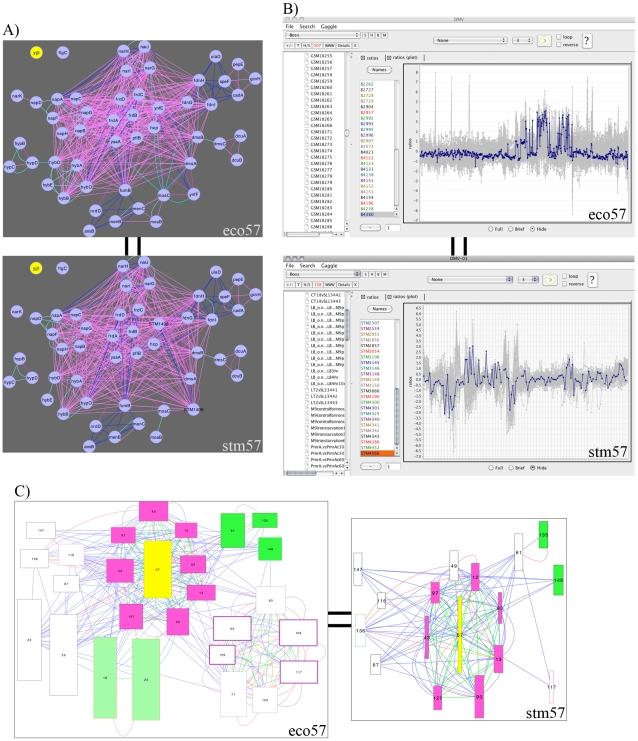
CMMR linked Gaggled tools I: Gene Network, Data Matrix Viewer, Bicluster Network.Expanding the Gaggle tools tab on the BiclusterCard for multi-species bicluster E. coli – S. Typhimurium bicluster 57, reveals a list of links (buttons) to the various Gaggle tools. (A) The Gene Associations button opens a Cytoscape goose that displays the core genes subnetwork for eco57 (top) and stm57 (bottom). The nodes represent genes and edges represent associations based on data from the compendium, indicated in yellow is gene yjjI. Edges are shared annotations: COG code (pink), Prolinks phylogenetic profile (purple), metabolic pathway (blue), operon (light cyan), and Predictome phylogenetic pattern (dark cyan). (B) The expression profiles for the genes and conditions from eco57 (top) and stm57 (bottom) can be explored by opening the Data Matrix Viewer. Using the FireGoose, the bicluster's genes and conditions can be broadcast from the BiclusterCard. We can see how the expression profile of gene yjjI (indicated by the colored line) matches other profiles in the bicluster. (C) The Bicluster Network button opens a Cytoscape goose to display the complete bicluster network where each node is a bicluster (width and height proportional to number of genes and conditions, respectively) and edges represent any shared properties and annotations. We can explore the related bicluster subnetwork for bicluster 57 (yellow), eco57 (left) and stm57 (right), by broadcasting the list of related biclusters (using the FireGoose) from the BiclusterCard to select those biclusters and display them in a new window. There are 10 additional biclusters in the eco57 subnetwork. Node fill color represents significant COG annotation, border color represents significant GO annotation, node border thickness represents residual, and edge color represents shared COG (green) KEGG (red), or GO (blue) annotations.